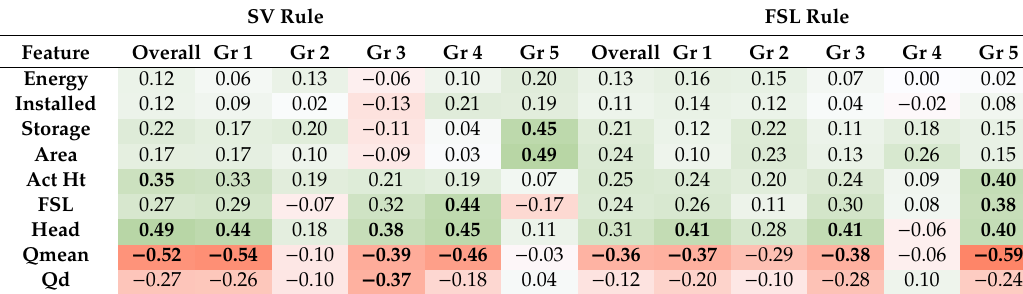
Table 3. Pearson correlation R values for overall HA and individual IHA parameter groups (Group 1–5 IHA parameters are denoted as Gr1–5) among logarithmic predictor values for features (Energy: annual energy production; Installed: installed capacity; Storage: reservoir storage capacity at full supply level; Area: reservoir surface area at FSL; Act Ht: active storage height; FSL: full supply level; Head: design head of the scheme; Qmean: mean annual flow of the river and Qd: design discharge of the scheme) for the 3S basin under the SV-rule curve and FSL-rule curve (green and red indicate positive and negative correlations, bold values represent p < 0.05). SV Rule FSL Rule